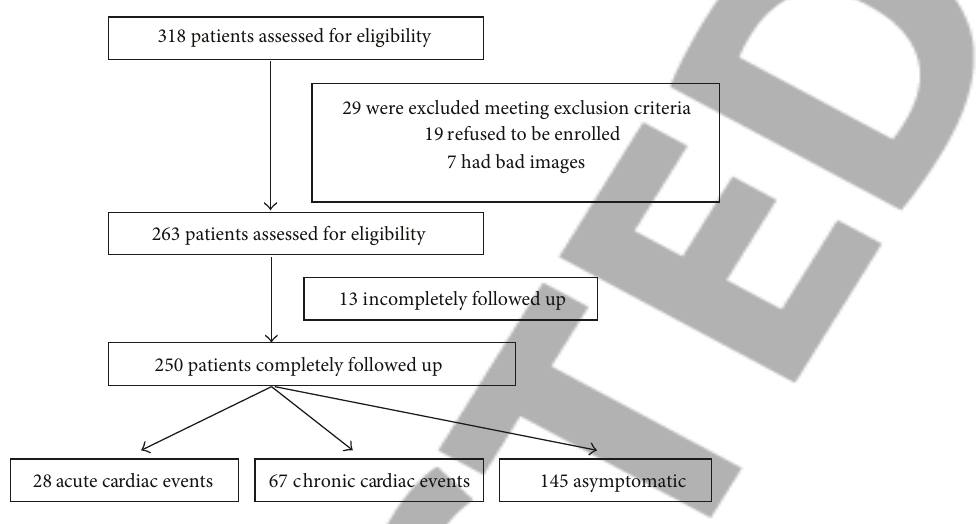
Figure 1: Flow chart of the study